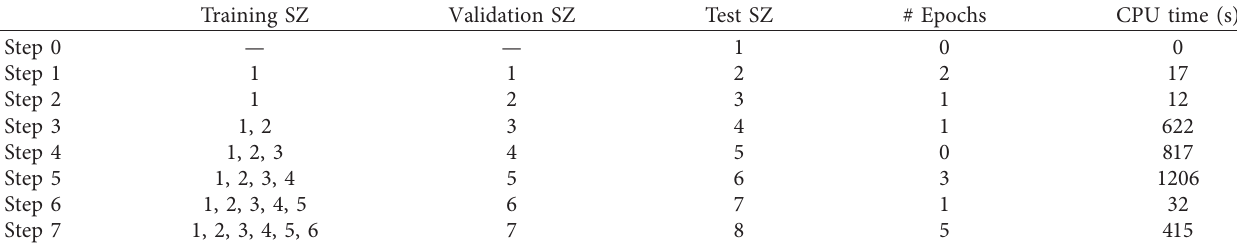
Table 9: Steps of the cross-patient seizure detection process for patient